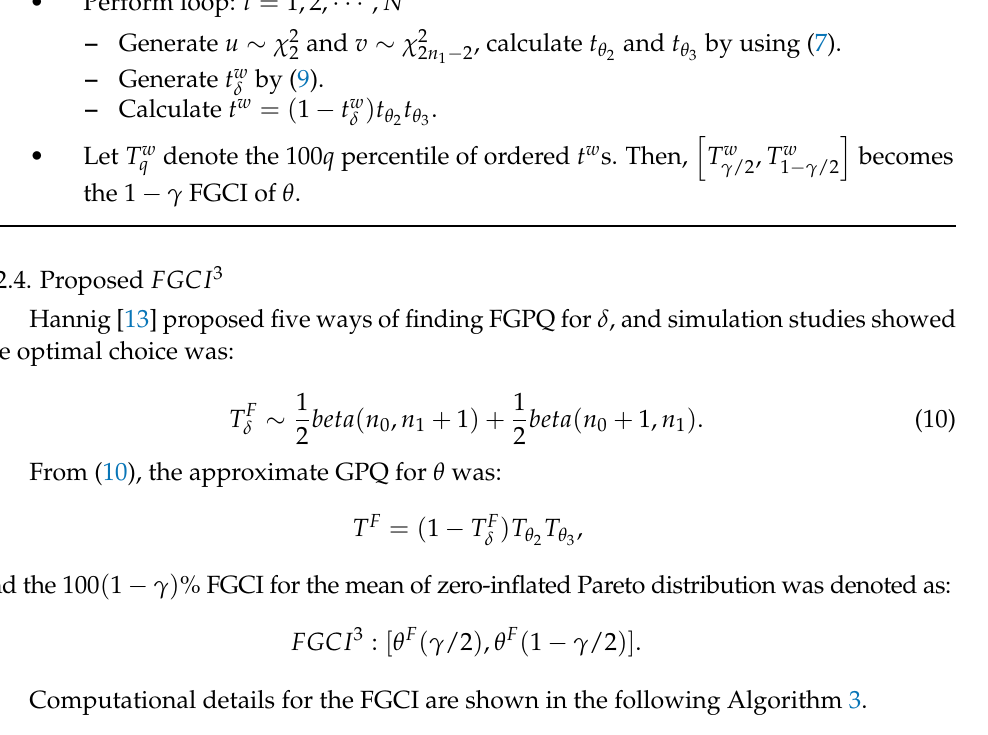
Algorithm 2: For a given sample, determine n 0 and n 1 , and calculate observation s and t